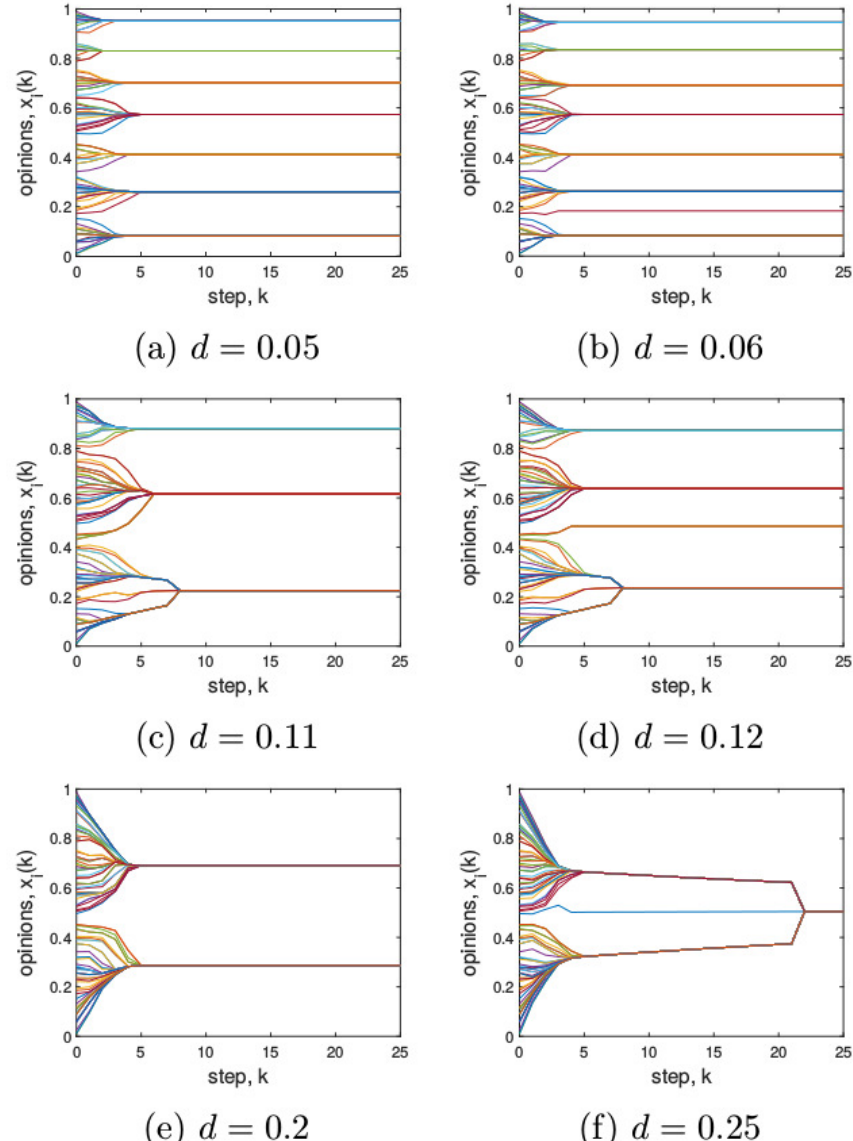
Figure 7. The HK model with n = 100 and various d (borrowed from Proskurnikov and Tempo